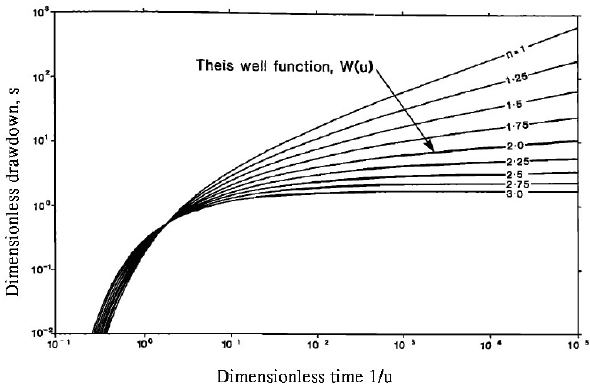
Fig. 7. Dimension drawdown and time curves (Modified from Fig. 2 in Barker (1988)).